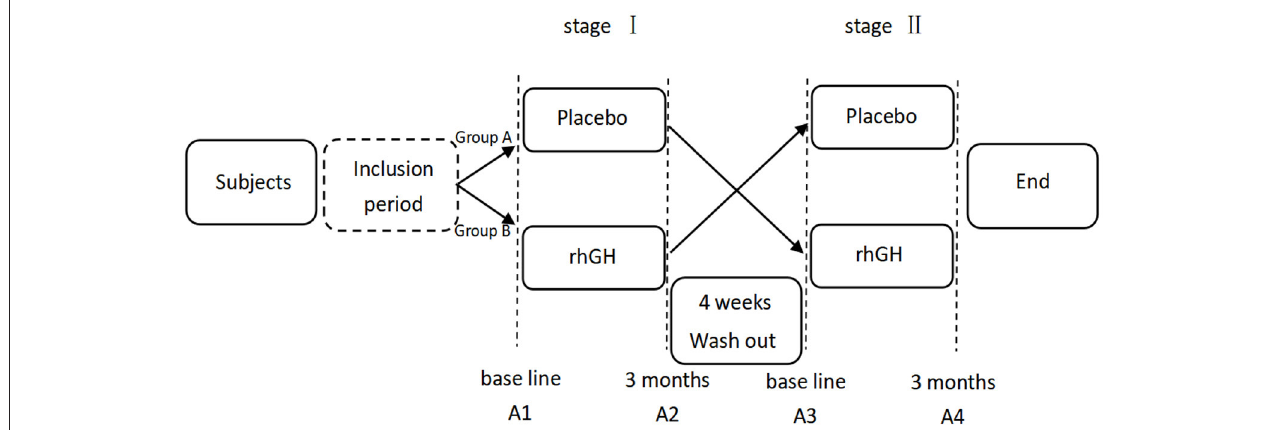
FIGURE 1 | Flow chart of the study protocol. A1/A2-A3/A4 stands for monitoring the treatment effect before and 3 months after the intervention of each stage.